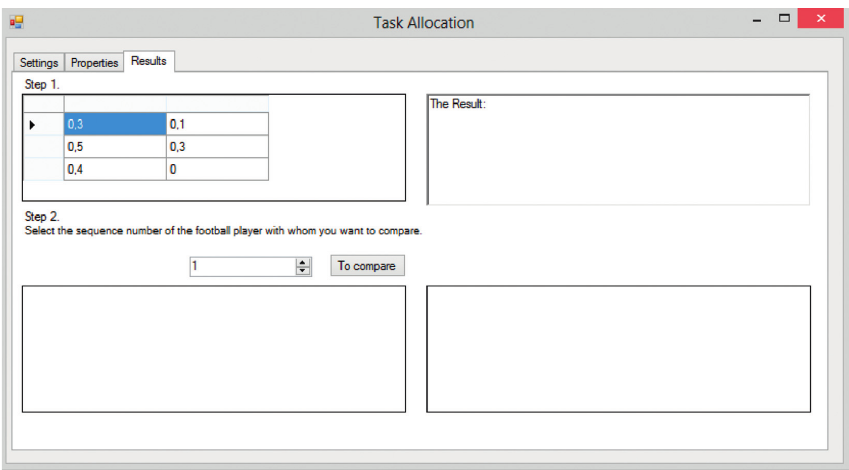
Figure 5: Selection of the sequence number of the MO